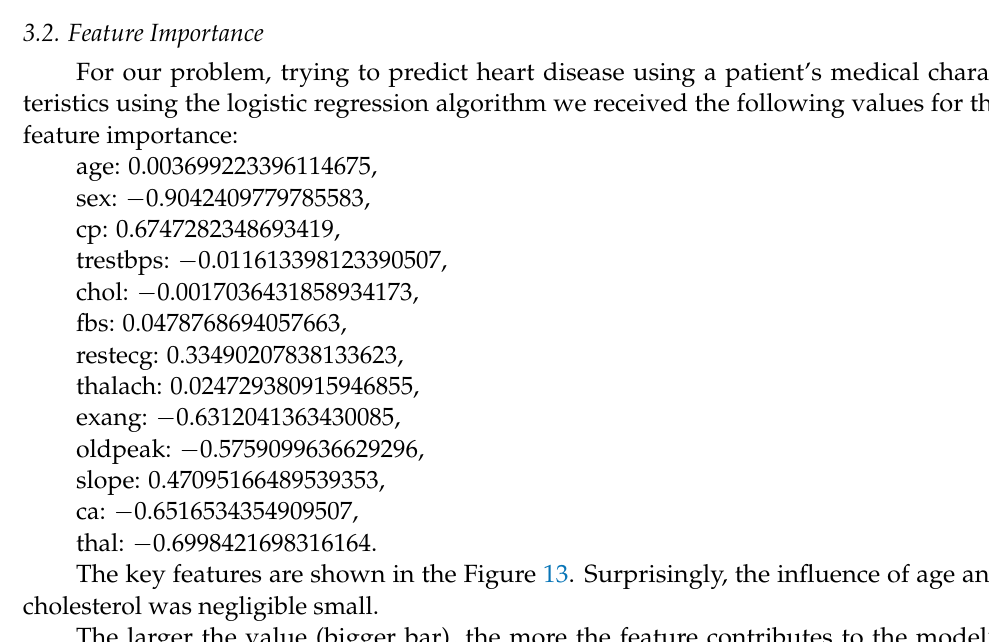
Figure 12. Cross-Validated metrics.